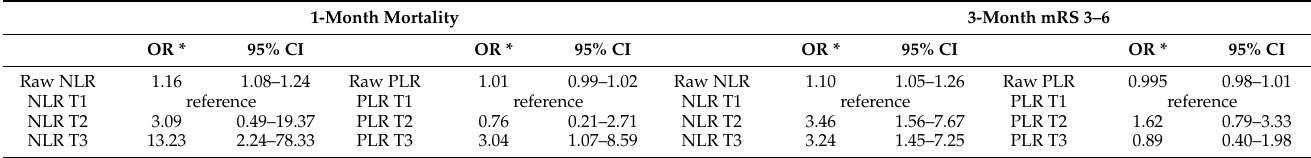
Table 3. Multivariate analysis showing the impact of NLR and PLR on clinical outcomes.